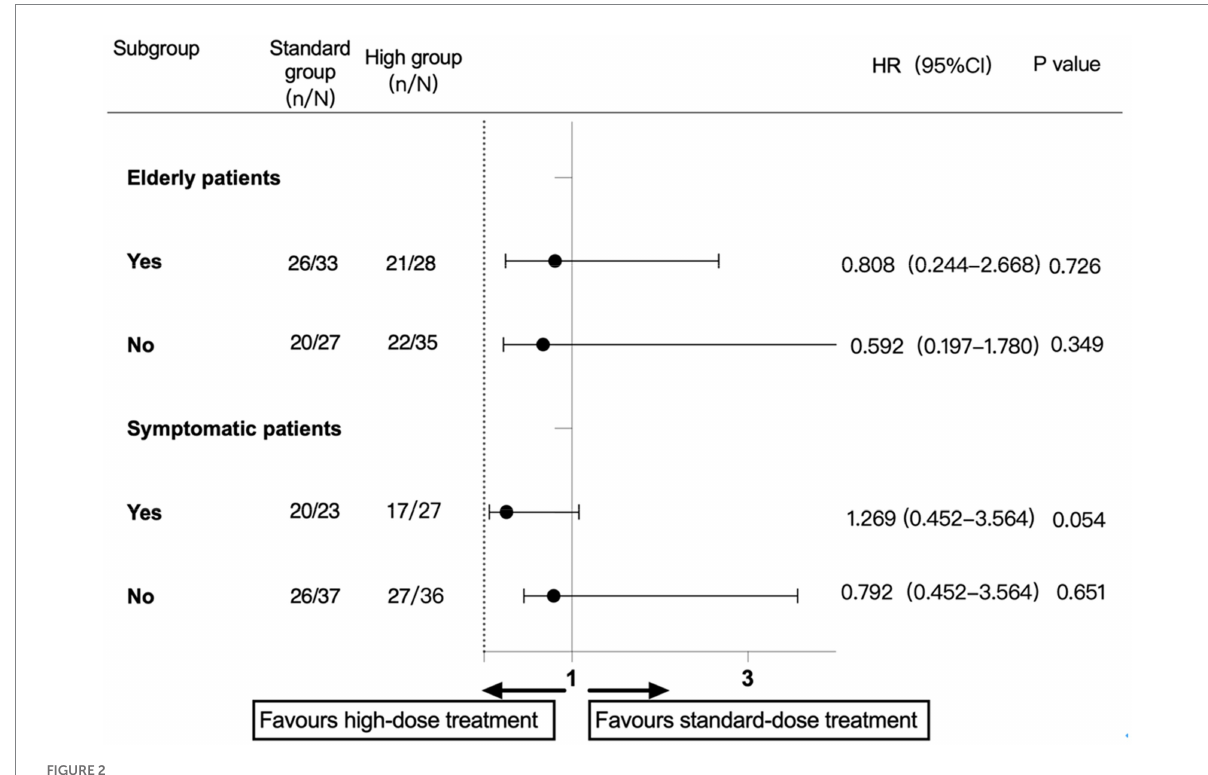
FIGURE 2 Subgroup analysis of the component primary outcome.